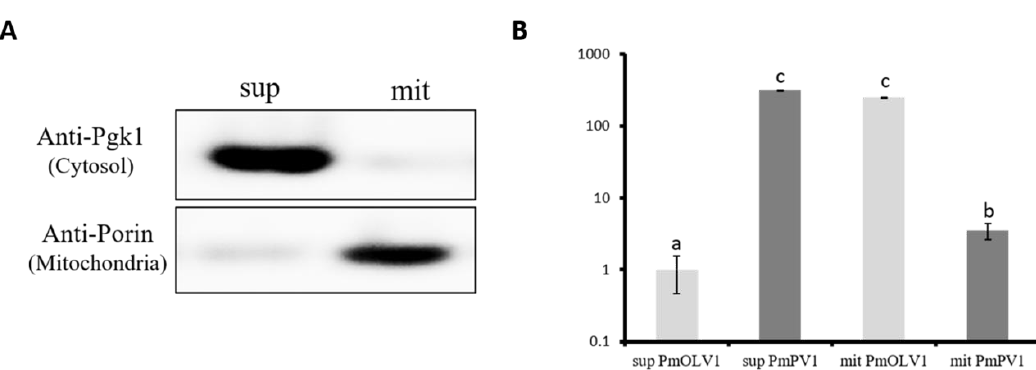
Figure 4. ( A ) Quality control of mitochondrial fraction isolation. The distinct fractions of supernatant (sup) and mitochondria (mit) were analyzed by immunoblotting with anti-Pgk1 (a cytosolic marker) and anti-Porin (a mitochondrial marker) antibodies, respectively, and equal amounts of protein were loaded for the blot analysis. ( B ) Comparison of PmPV1 and PmOLV1 expression levels in mitochondrial pellet (mit) and the residual supernatant (sup) from mitochondrial isolation. Values on the y-axis coordinate represented the expressional fold change relative to PmOLV1 in the supernatant fraction (sup PmOLV1) calculated with the delta delta Ct approach. Bars with di ff erent letters were statistically significant based on t -test at a significance level of 0.005.